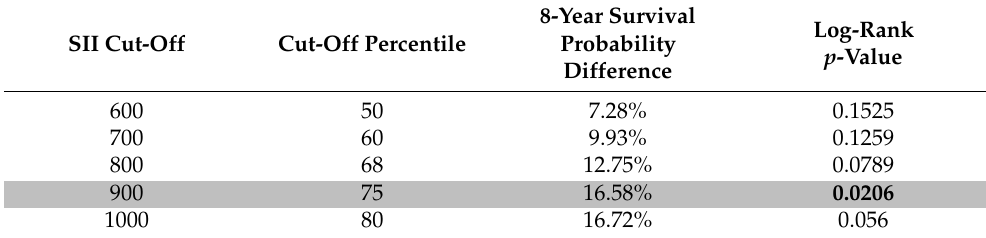
Table 2. Differences in survival probabilities derived using different SII